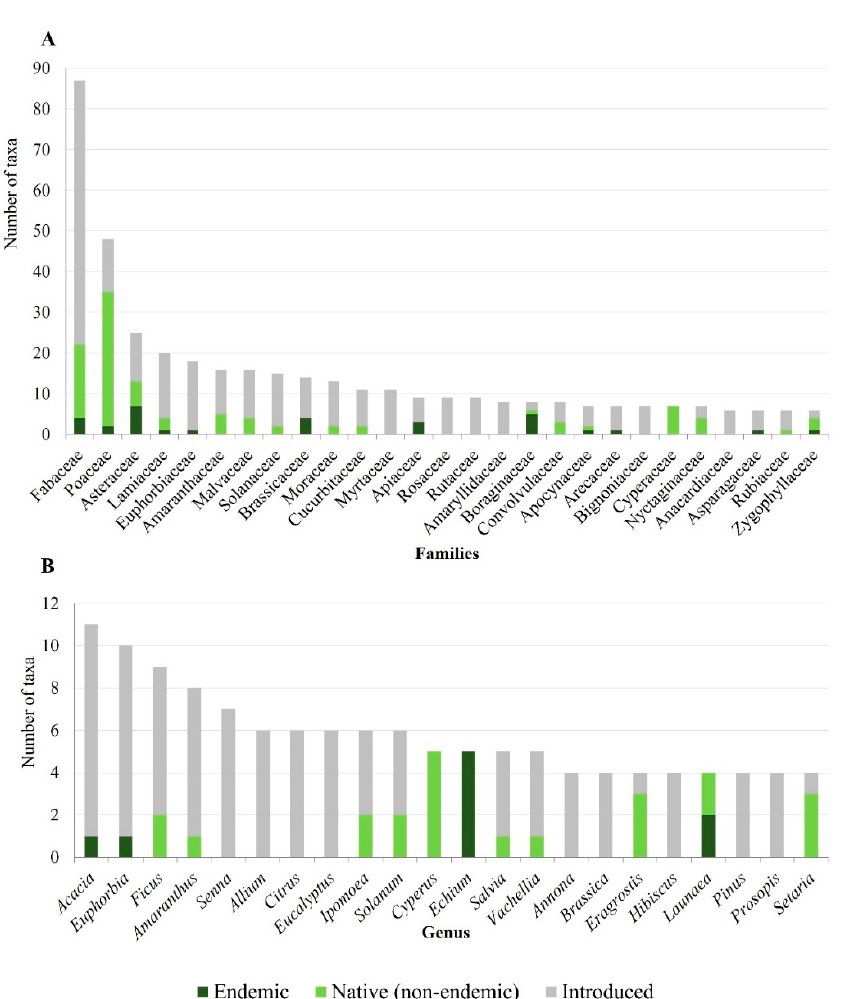
Figure 1. Number of endemics, native non-endemics and introduced useful taxa identified in Cabo Verde. ( A ) Family (only families with more than five taxa are represented); ( B ) Genus (only genera with more than three taxa are represented).